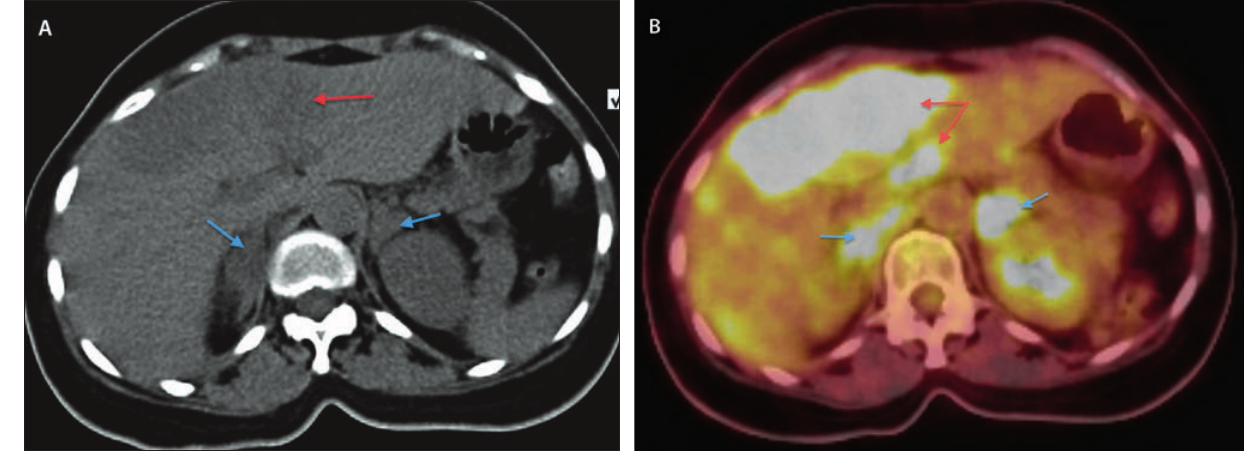
Fig. 4. Adrenal metastases in a 56-year-old woman with advanced breast carcinoma. (A) Axial unenhanced CT scan image shows bilateral ill-defined adrenal masses (blue arrows) and a large hypodense hepatic lesion (red arrow). (B) Axial PET image demonstrates intense FDG uptake in both adrenal (blue arrows) and liver lesions (red arrows) consistent with